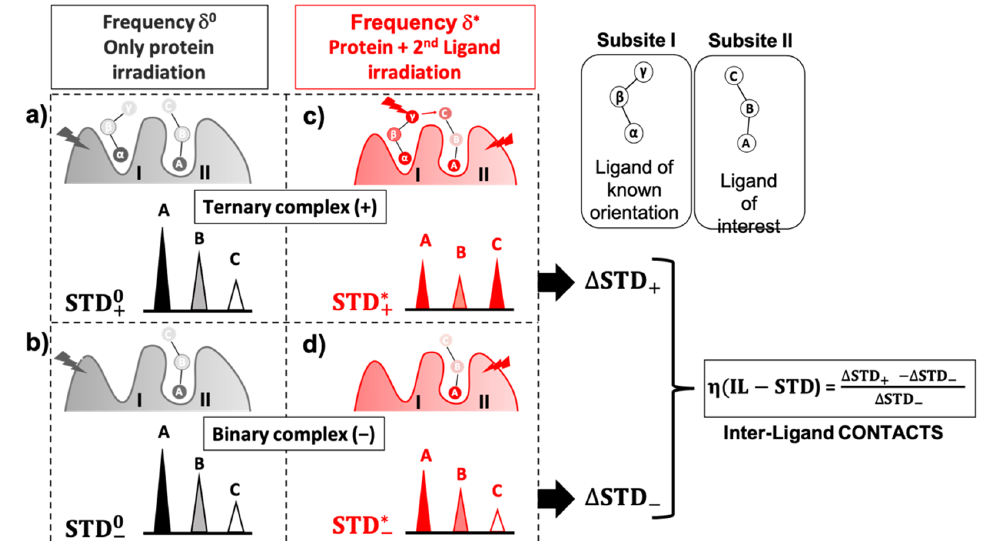
Figure 3. Cartoon representing the IL-STD NMR approach for a system consisting of two ligands binding to a protein in adjacent subsites. ( a , b ) In black, STD NMR experiments with selective irradiation ( δ 0 ) on protein protons, where the experiments are run with the protein containing either both ligands ( a ), ternary complex, “+” giving rise to STD 0 + , or just the ligand of interest ( b ), binary complex, “ − ”, giving rise to STD 0 − . The “+” or “–” sign refers to the presence or absence of the reporter ligand of known orientation in the binding subsite-I adjacent to the ligand of interest (subsite-II). ( c , d ) In red, STD NMR experiments with selective irradiation ( δ *) on both, the reporter ligand proton γ (expected to be spatially close to proton/s of the ligand of interest , e.g., proton C), as well as the protein protons, again with the samples of protein containing either both ligands ( c ), ternary complex, “+”, giving rise to STD ∗ + , or just the ligand of interest ( d ), binary complex, “ − “, giving rise to STD ∗ − . Delta-STD values ( ∆ STD + = STD ∗ + − STD 0 + or ∆ STD − = STD ∗ − − STD 0 − ) identify differences in STD intensities of the ligand of interest as a consequence of irradiating at the frequency δ * of the reporter ligand in the adjacent subsite, in comparison to δ 0 , whether the reporter ligand is present or not, respectively. η ( IL − STD ) additionally removes potential contributions from the presence or absence of the reporter ligand and normalizes values against variations in the binding epitope of the ligand of interest simply due to to different levels of protein saturation between δ 0 and δ *, readily unveiling the existence of inter-ligand contacts in the bound